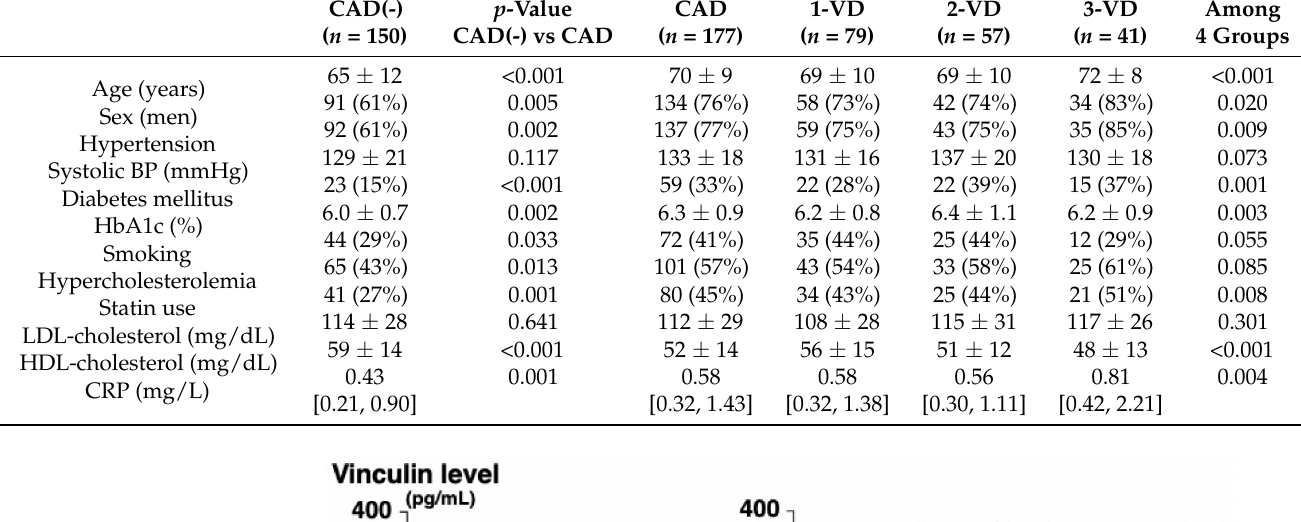
Table 1. Clinical characteristics of CAD(-) and CAD groups.